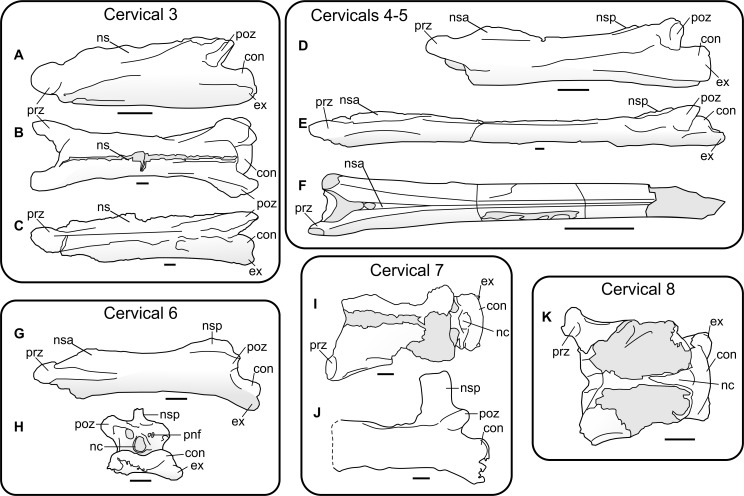
Characteristics of azhdarchid vertebrae across their cervical series, demonstrated by several azhdarchid taxa.(A) Azhdarcho lancicollis cervical III (ZIN PH 131/44), left lateral aspect; (B–C) Quetzalcoatlus sp. cervical III (TMM 41544.16) in dorsal (B) and left lateral (C) aspect; (D) A. lancicollis cervical IV (ZIN PH 144/44), left lateral aspect; (E) Q. sp. cervical V (TMM 41455.15), left lateral aspect; (F) Arambourgiania philadelphiae cervical V (UJA VF1), dorsal aspect; (G–H) A. lancicollis cervical VI (ZIN PH 147/44) in left lateral (G) and posterior (H) aspect (note especially large neural spine); (I) A. lancicollis cervical VII (ZIN PH 138/44), dorsal aspect; (J) Phosphatodraco cervical VII (OCP DEK/GE 111), left lateral aspect; (K) A. lancicollis cervical VIII (ZIN PH 137/44), dorsal aspect. Abbreviations as for Fig. 2, also with con; condyle; ex, exapophysis; ns, neural spine. (A, D, G–H) and (K) after Averianov (2010); (F) after Frey & Martill (1996); (J) after Suberbiola et al. (2003).